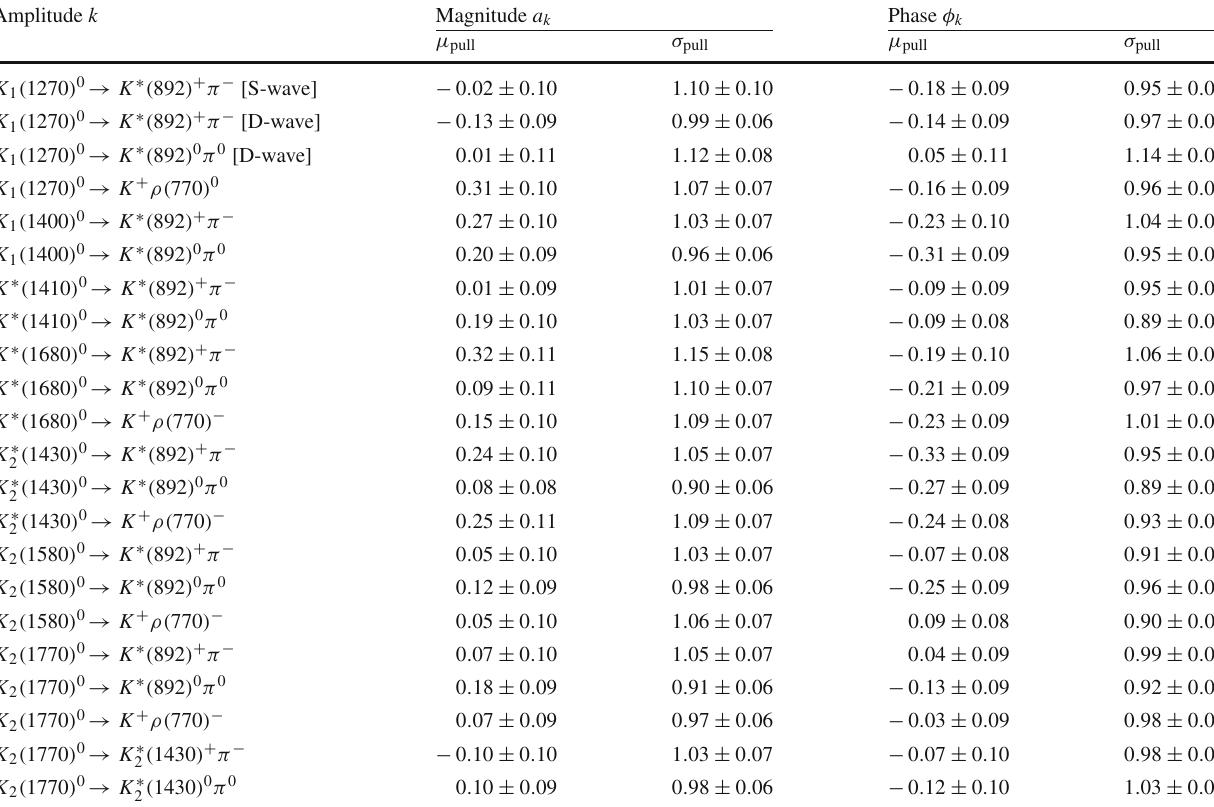
Table 5 Pull parameters of the fit to B 0 → K + π − π 0 γ samples for all magnitudes and phases relative to the amplitude with the S-wave